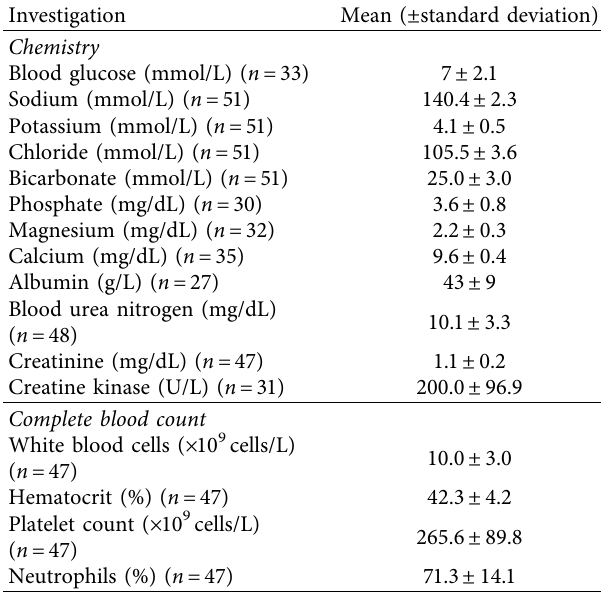
Table 4: Clinical investigation.